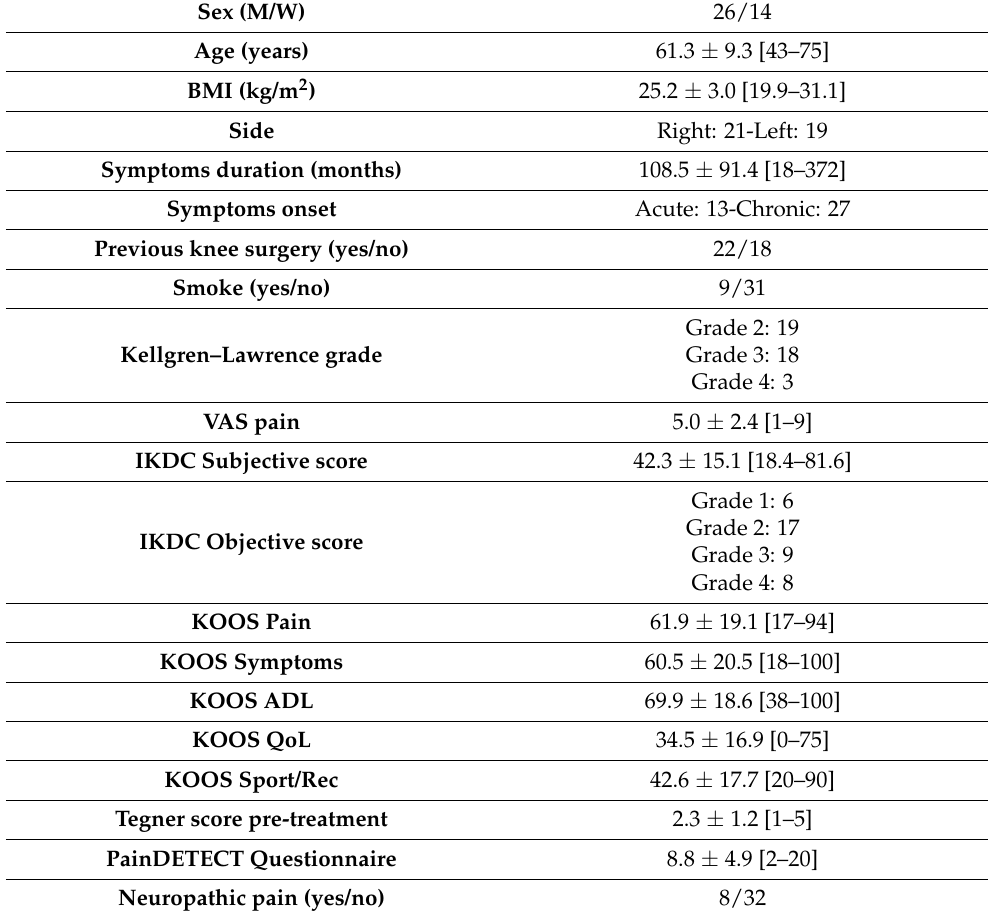
Table 1. Included patients’